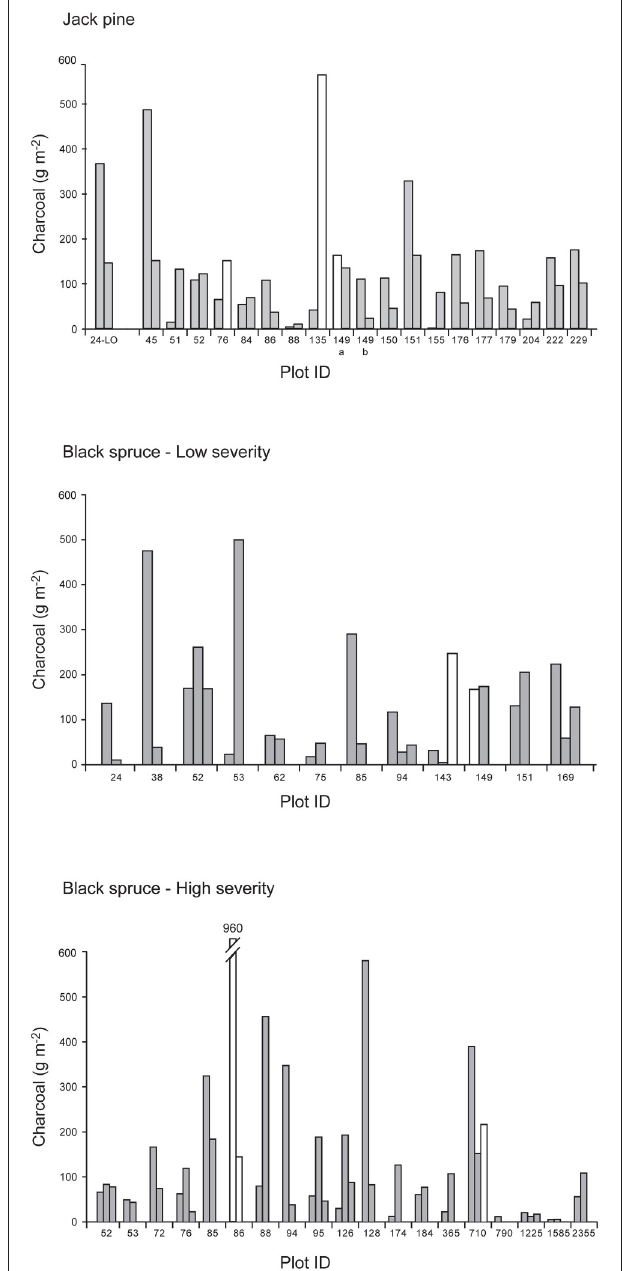
FIGURE 1 | Charcoal content for the two or three individual monoliths sampled at each site. Open bars indicate monoliths where the charcoal content was likely underestimated (indicated with 4 stars in Figure 2 ). Refer to Table 1 for explanation of plot identification (Plot